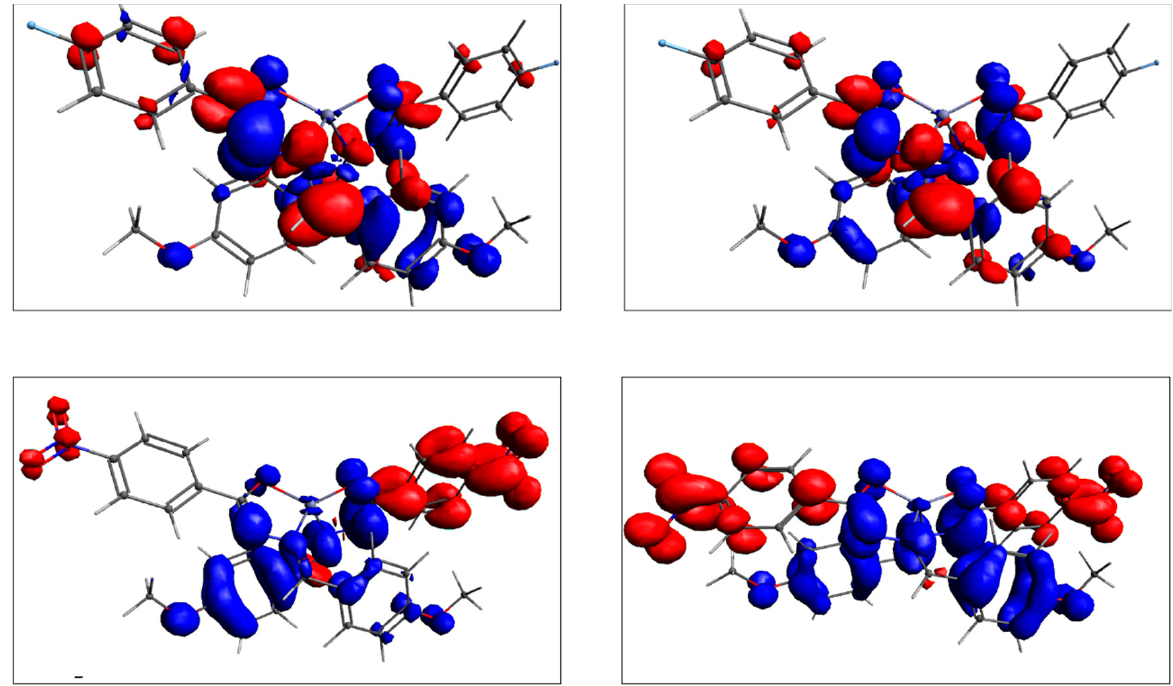
Figure 11. Electron differential density between excited states and ground states in Ac1 ( above ) and Ac2 ( below ). Positive and negative density iso-values are indicated in red and blue, respectively. Differential excitation in the ground state equilibrium geometry ( left ) and excited relaxed geometries ( right ). The iso-surface is calculated at 0.001 |e|/a 0 for all plots.